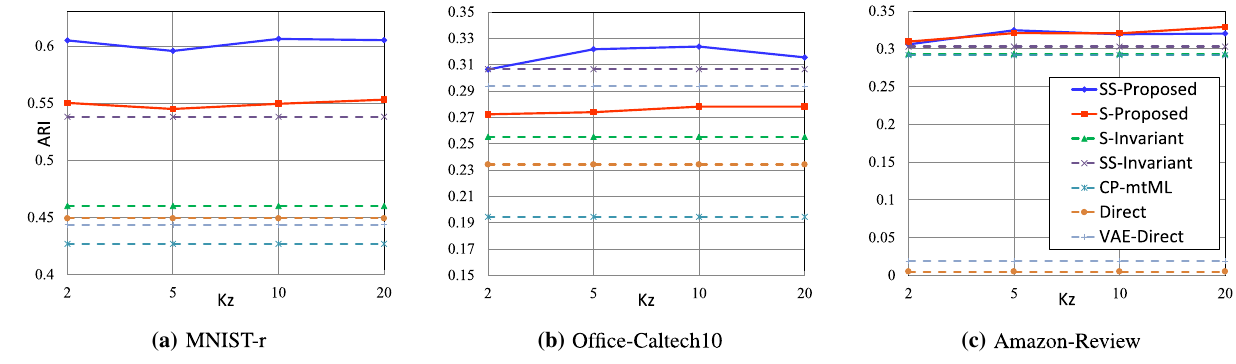
Fig. 4 Average ARI over all unseen domains and the ratio of D L to D U of each dataset when the value of K z was changed